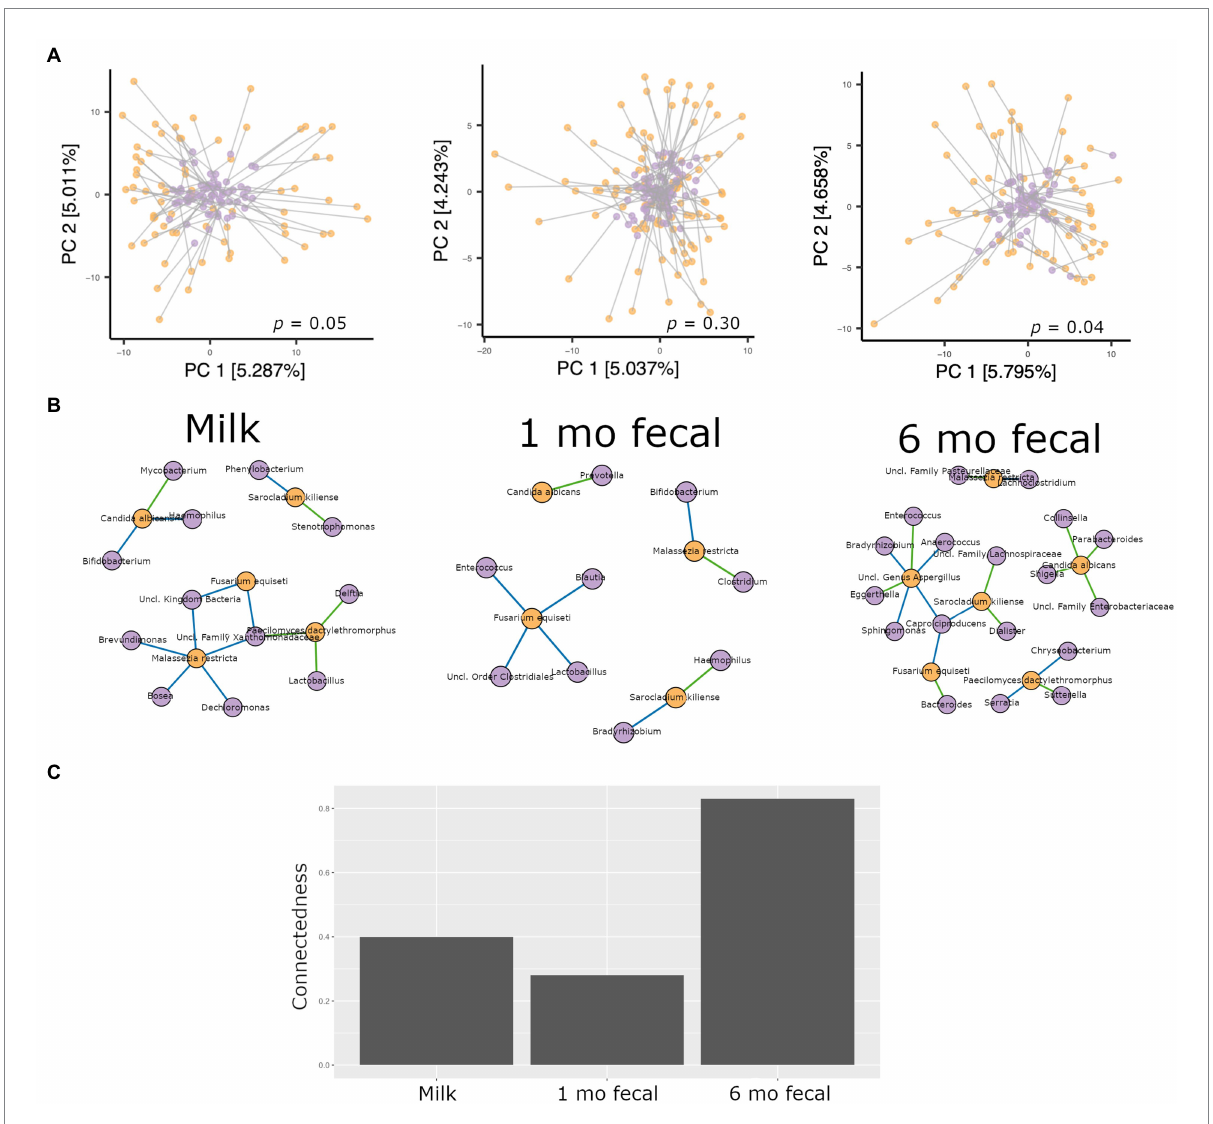
FIGURE 5 Analyses of interkingdom relationships in breastmilk (left panels), 1- and 6-month feces (middle and right panels, respectively). (A) Procrustes analysis comparing the spatial fit of unweighted Unifrac principal coordinate matrices of bacterial communities (purple spheres) and Bray-Curtis principal coordinate matrices of fungal communities (orange spheres) for each sample type. Breastmilk n = 75, 1-month feces n = 100, 6-month feces n = 69. (B) Interkingdom network maps of interactions between bacterial (purple spheres) and fungal (orange spheres) taxa by sample type (Breastmilk n = 75, 1-month feces n = 100, 6-month feces n = 69. Blue line, negative correlation; green line, positive correlation. (C) Interkingdom connectedness values (see Methods) for each sample